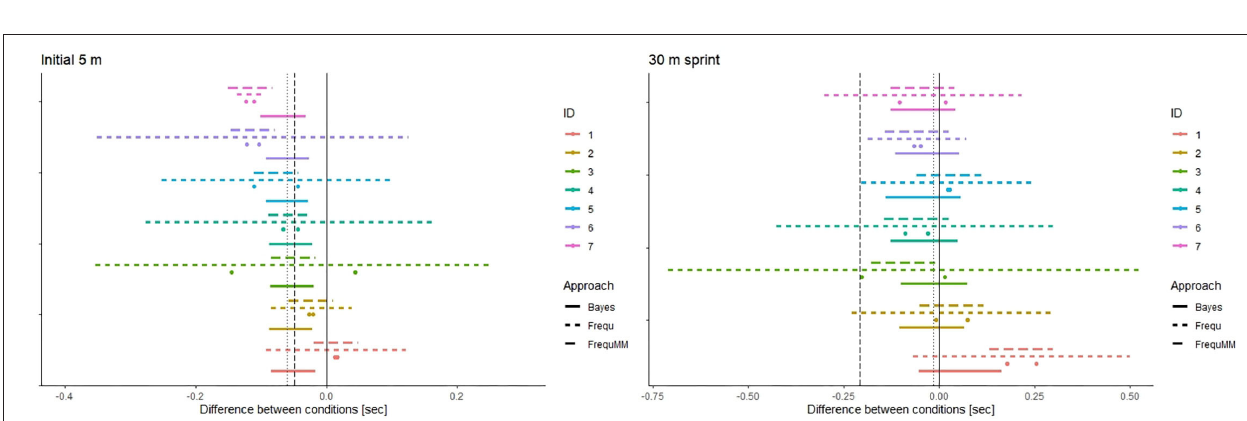
FIGURE 3 | Efficacy of cold-water immersion. 95% Bayesian credible intervals (highest posterior density intervals) and 95% frequentist confidence intervals, respectively. Dashed vertical line: prior mean, Dotted vertical line: data mean, Solid vertical line: Zero Bayesian credible intervals and frequentist confidence intervals calculated with the same data are displayed in one figure for comparison. Please keep in mind their fundamental disparity.